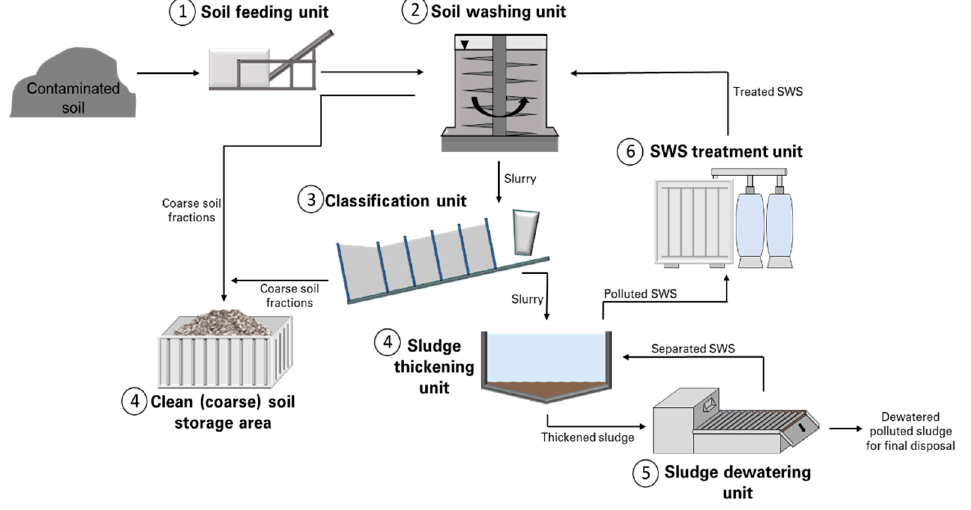
Figure 1. Soil washing system (adapted from www.dekonta.cz [27]). The numbers (1–7) indicate the steps of soil washing. steps of soil